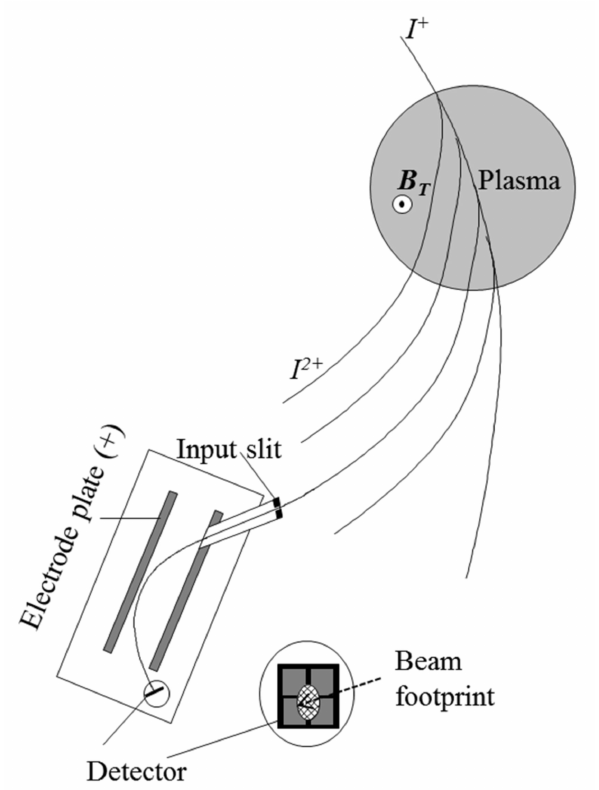
Figure 1. Illustration of the operation of a heavy-ion beam probe (HIBP). A heavy-ion beam I + is injected into the plasma perpendicularly to the toroidal magnetic field ( B T ) producing a quasi-circular trajectory due to the Lorentz force. While colliding with the plasma electrons, the primary beam ( I + ) is ionized and produces a fan of secondary beams along the plasma column ( I 2+ ). The trajectory of each secondary beam is determined by half of the Larmor radius with respect to the primary